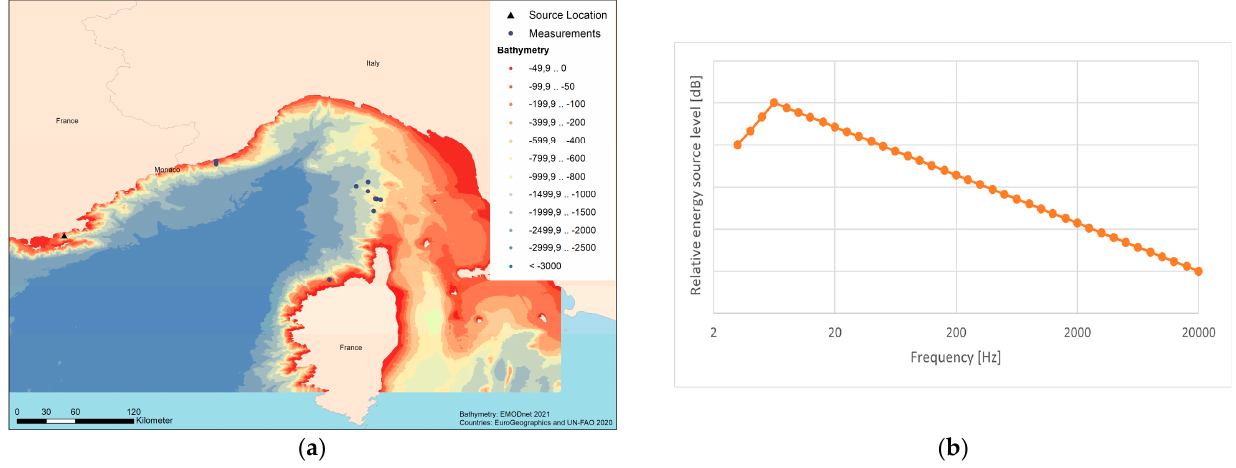
Figure 12. ( a ) Bathymetry in the study area between source (black triangle) and measurement locations in the Ligurian Sea (blue dots). ( b ) Idealistic frequency distribution used for the source description of the airgun array.